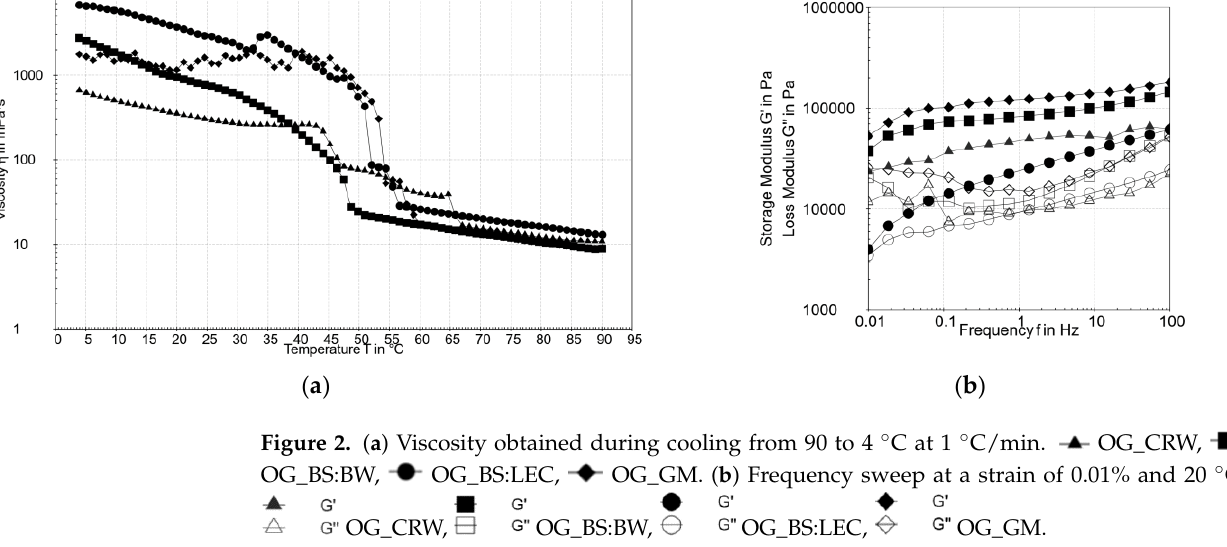
Figure 2. ( a ) Viscosity obtained during cooling from 90 to 4 °C at 1 °C/min. OG_CRW, OG_BS:BW, OG_BS:LEC, OG_GM. ( b ) Frequency sweep at a strain of 0.01% and 20 °C.